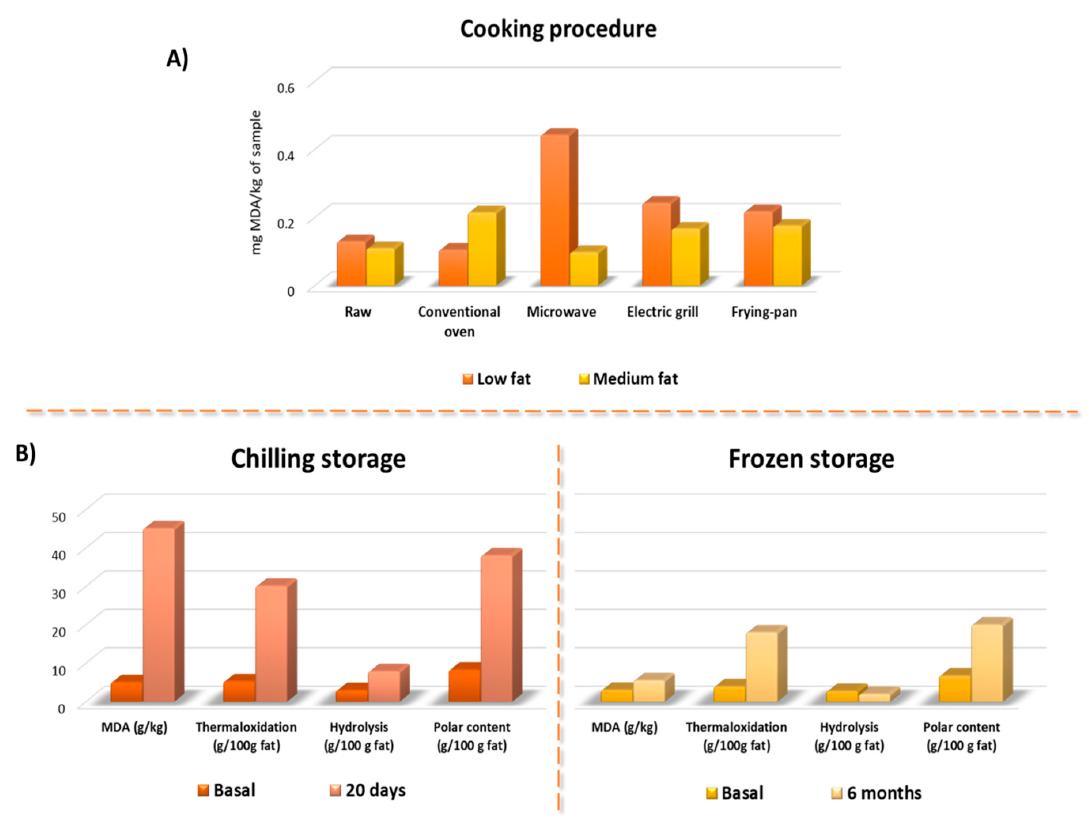
Figure 3. Oxidation compounds formation according to the cooking and storage method. ( A ) Results of the MDA formation in beef steaks with low and medium fat content subjected to different cooking methods. ( B ) Oxidation compounds formation in preserved meat in chilling or frozen storage. Modified from Serrano et al. [62] and Librelotto et al. [64] . With Meat Science permission solicited and still pending.